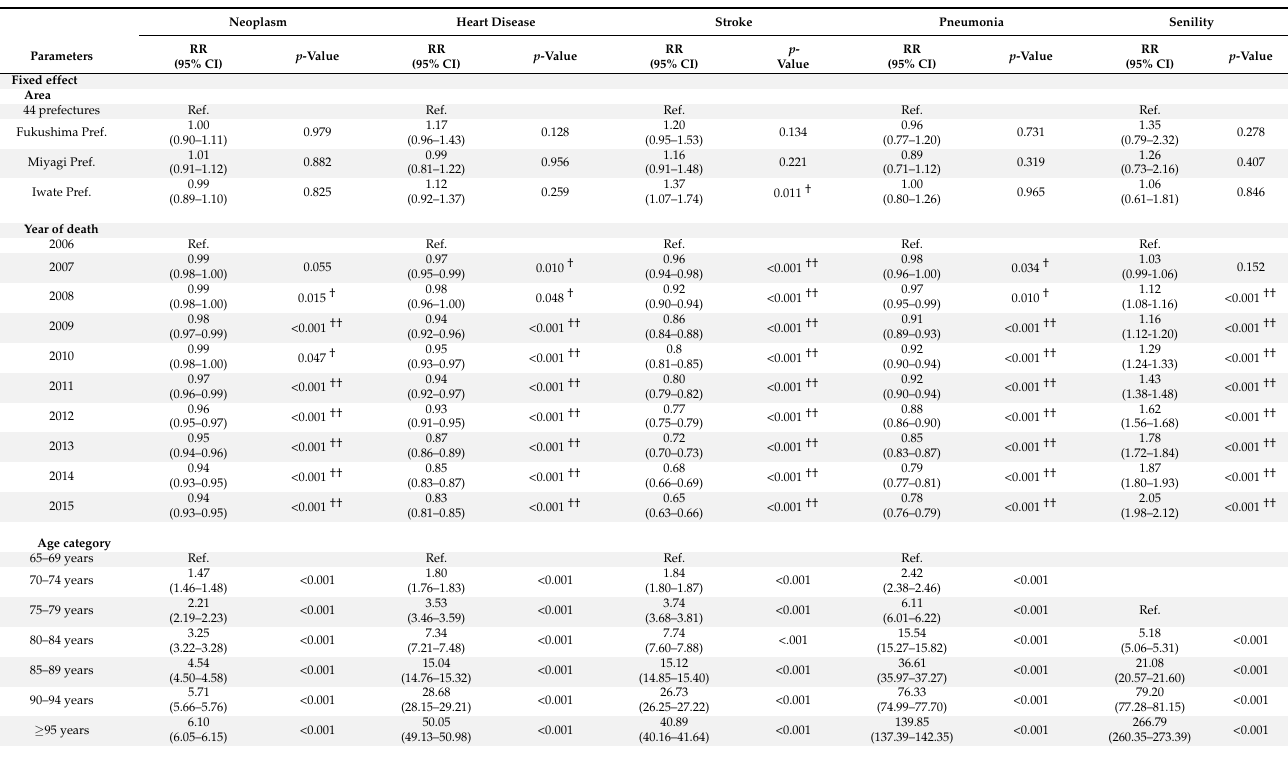
Table A2. Risk ratios and confidence intervals for fixed effects and interaction terms according to the cause of